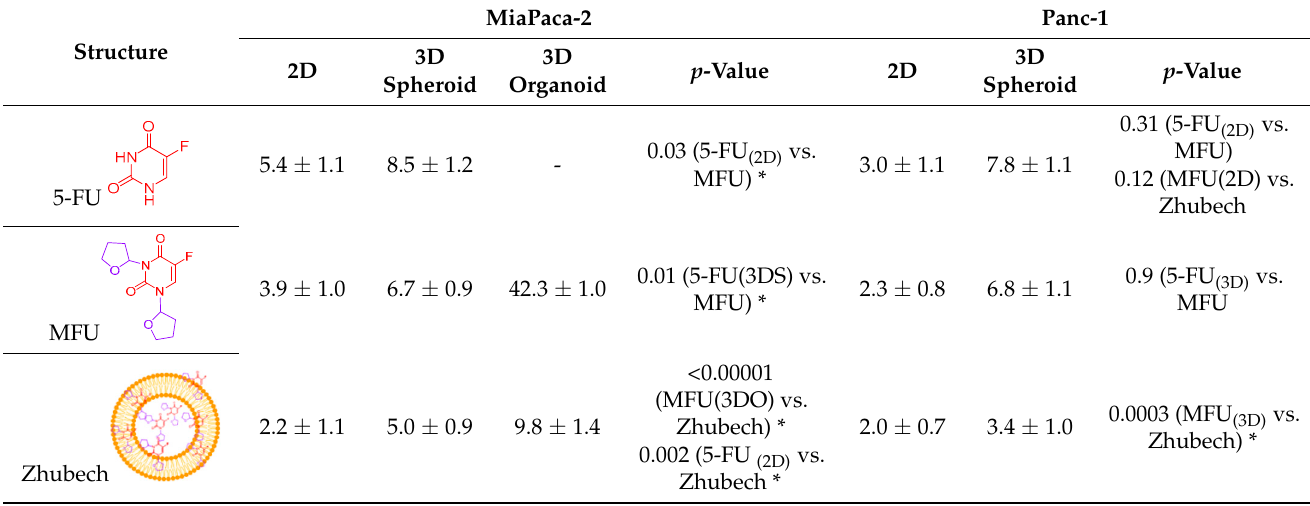
Figure 5. Cell viability: effects of Zhubech formulation on Panc-1 and MiaPaca-2 cell growth after 48 h exposure. ( a , b ) % viability of Panc-1 in 2D and 3D spheroids culture, respectively; ( b – d ) % viability of MiaPaca-2 in 2D and 3D spheroid culture respectively; ( e ) % viability of MiaPaca-2 in 3D organoid culture (after 7 days of exposure with MFU and Zhubech formulation). Table 3. Comparing the IC 50 values of 5-FU compared to MFU and Zhubech in MiaPaca-2 and Panc-1 cell lines.